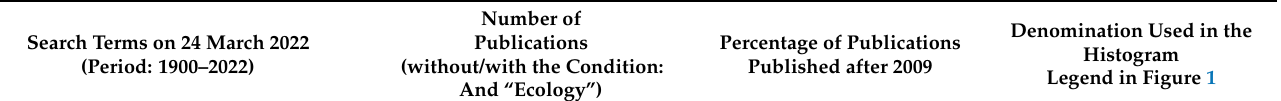
Table 1. Number of publications associated with the searches performed in the Web of Science Core collection database on 24 March 2022 (period: